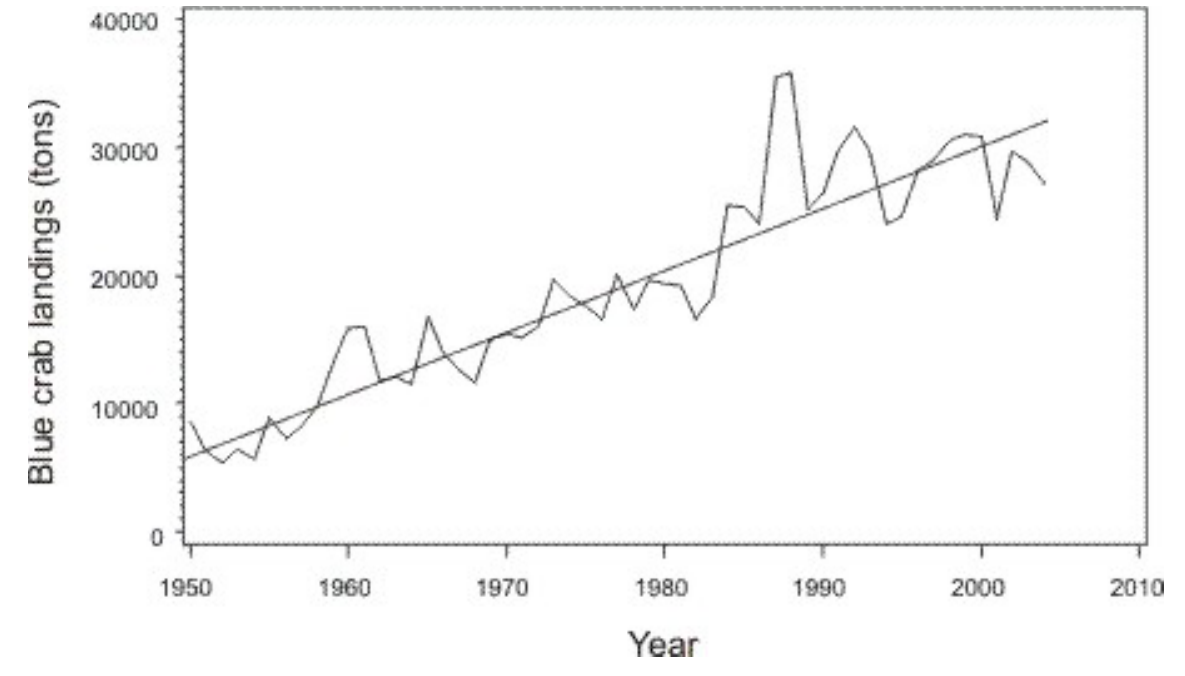
Fig. 3. Gulf of Mexico blue crab landings by year and the linear trend. The linear trend was estimated using linear regression: y = 477.8 x - 925,213, where y is the predicted annual landing and x is the year; R² = 0.84, p <